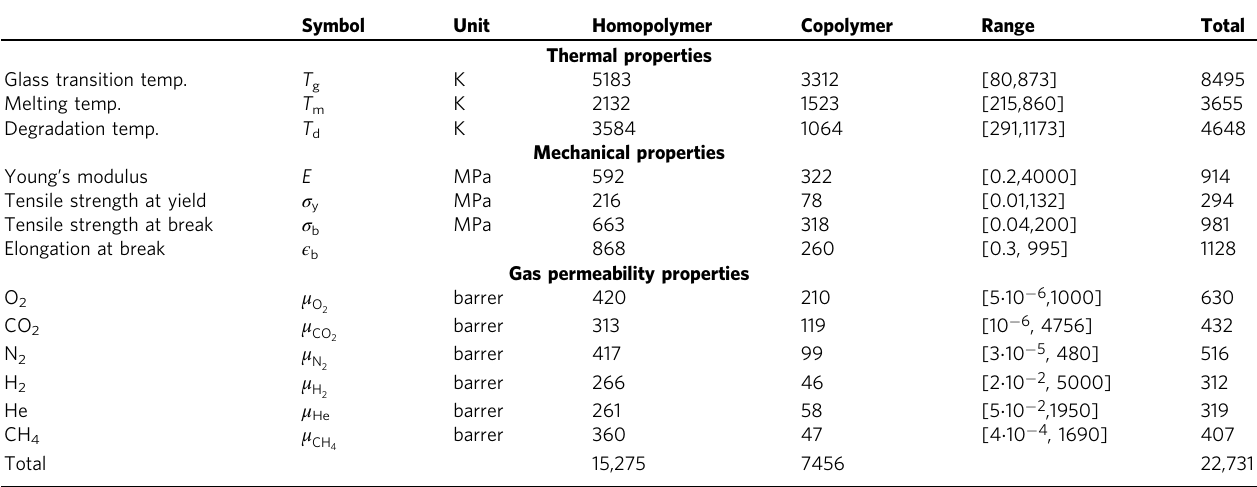
Table 1 Overview of our data set used for training the multitask predictors. Symbol Unit Homopolymer Copolymer Range Thermal properties Glass transition